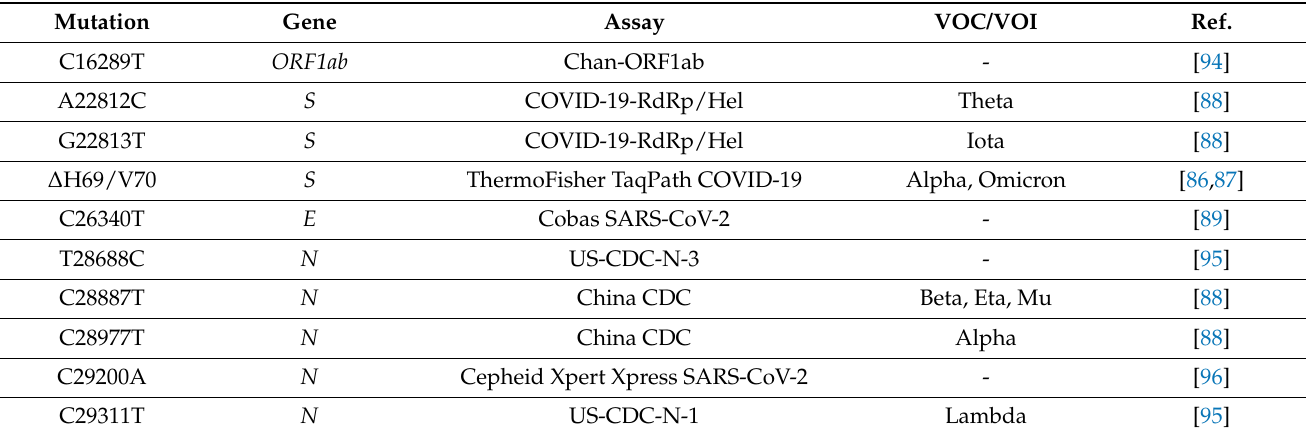
Table 5. Mutations associated with failures in COVID-19 diagnostic tests and their prevalence in VOCs and VOIs.